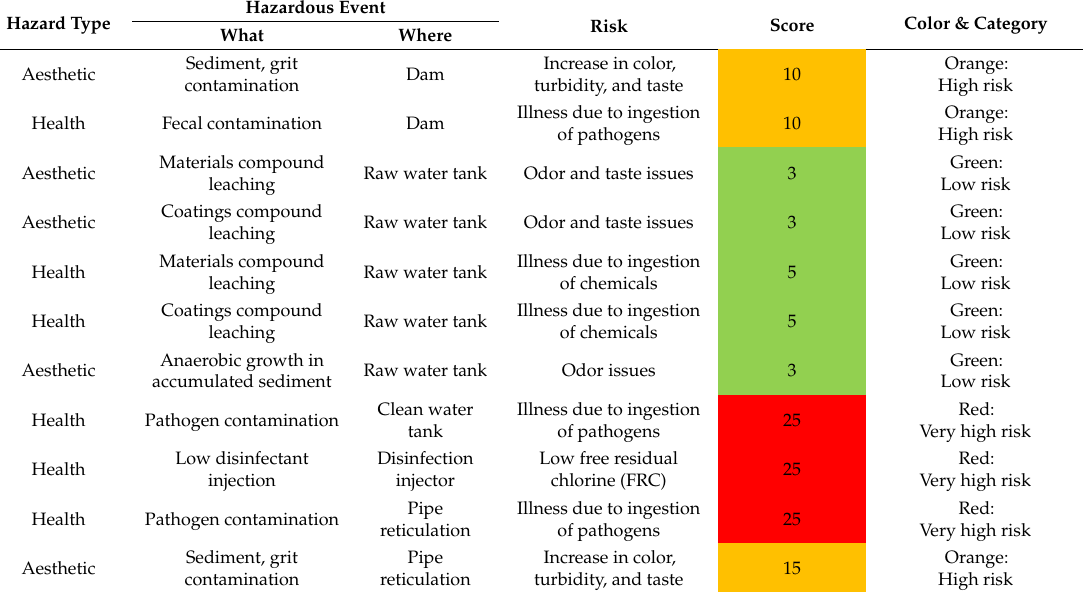
Table 3. Results of HIRA in drinking water